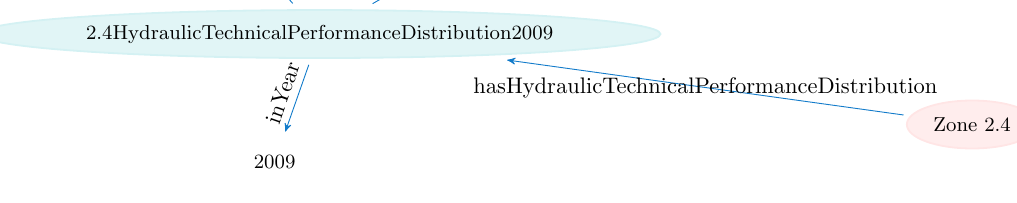
Figure 5. Example of graph representation according to the water Ontology.